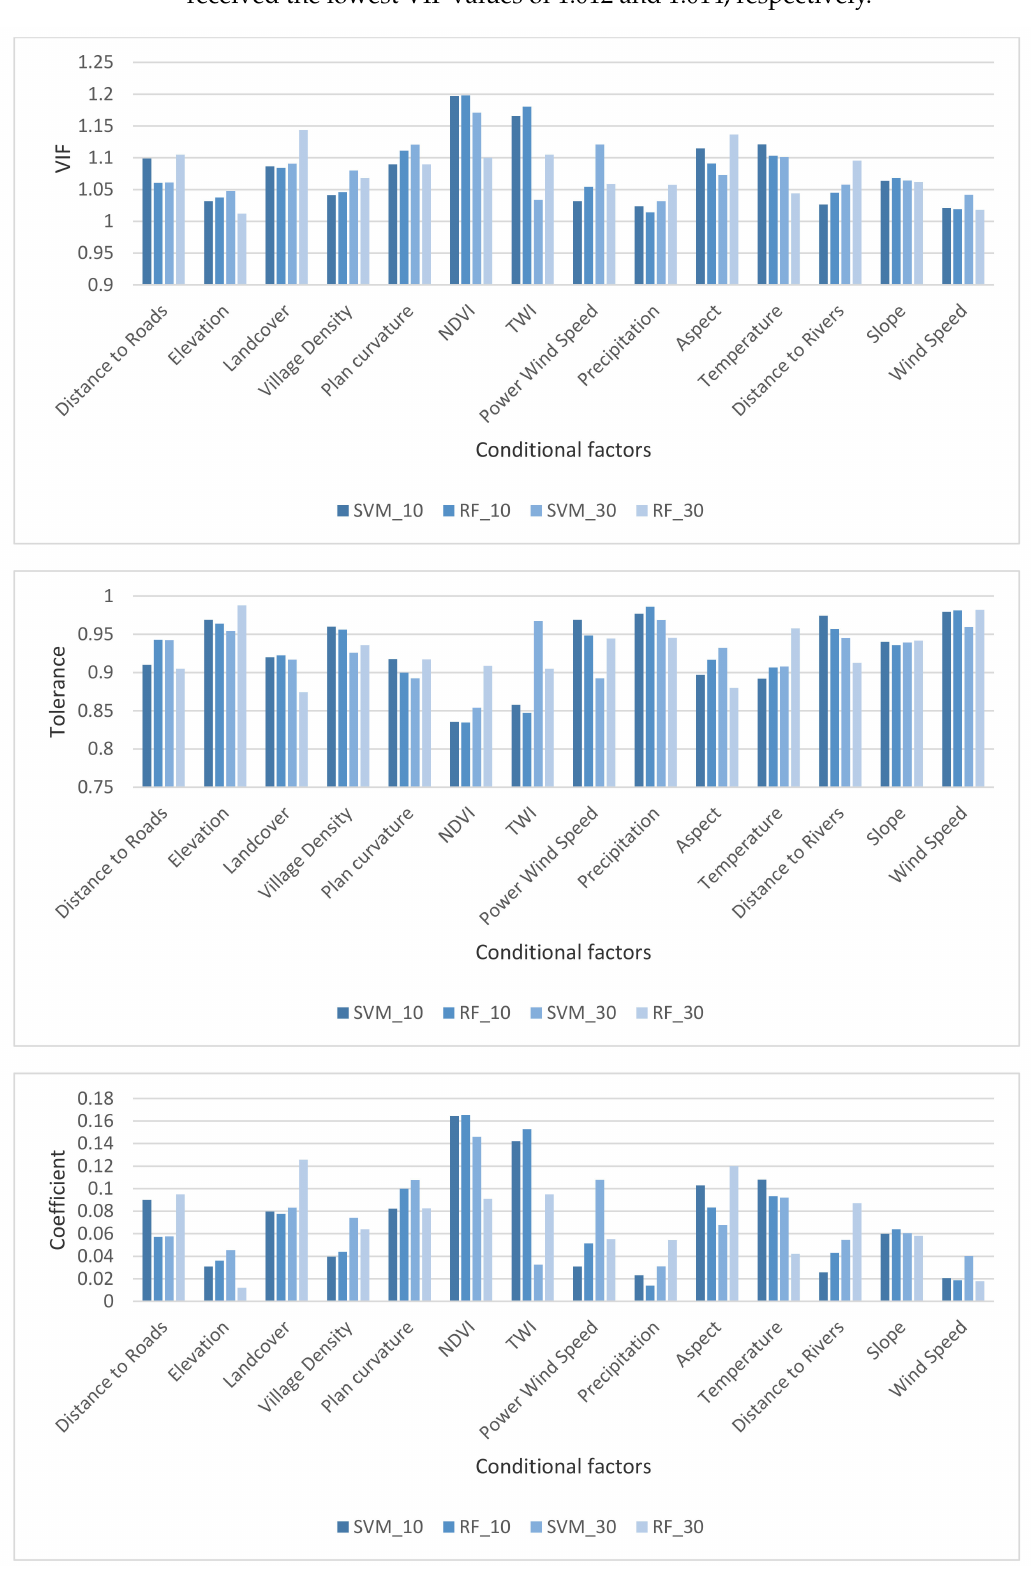
Figure 9. The multi-collinearity assessment and coefficient values for the applied WSP conditional factors in this